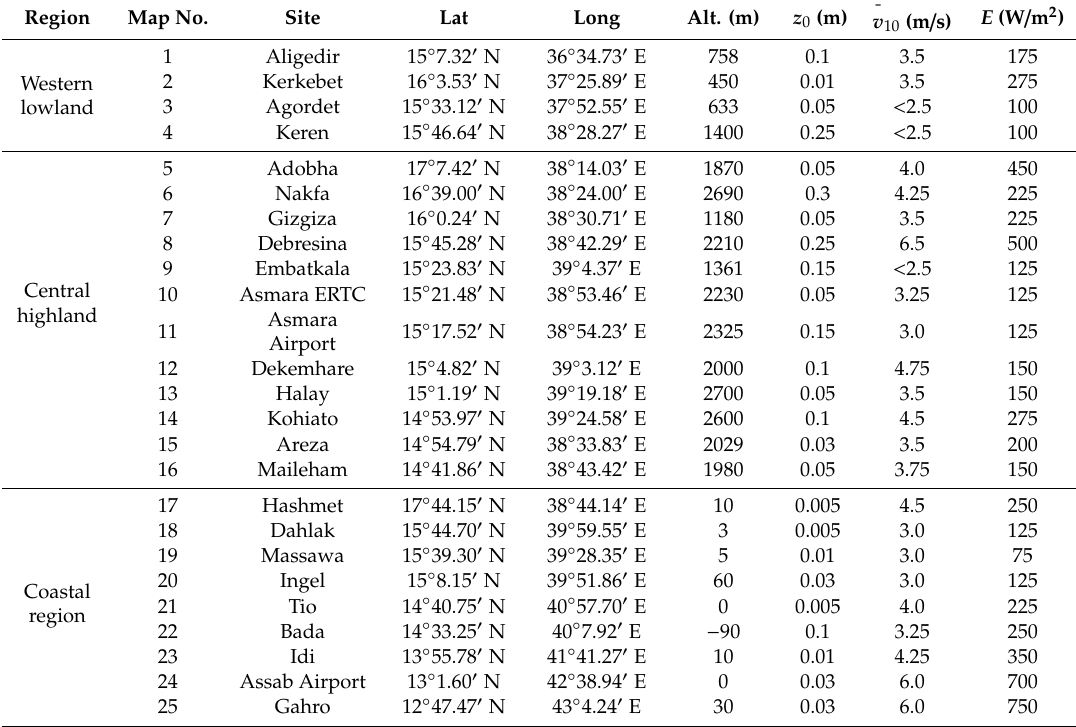
Table 1. Location of the studied wind sites. “Map no.” refers to the site location in Figure 1. The roughness length z 0 is visually estimated. The mentioned wind speed (10 m above ground) and wind power density E (100 m above ground) is from the Global Wind Atlas (GWA) v3.0 [21]. Region Map